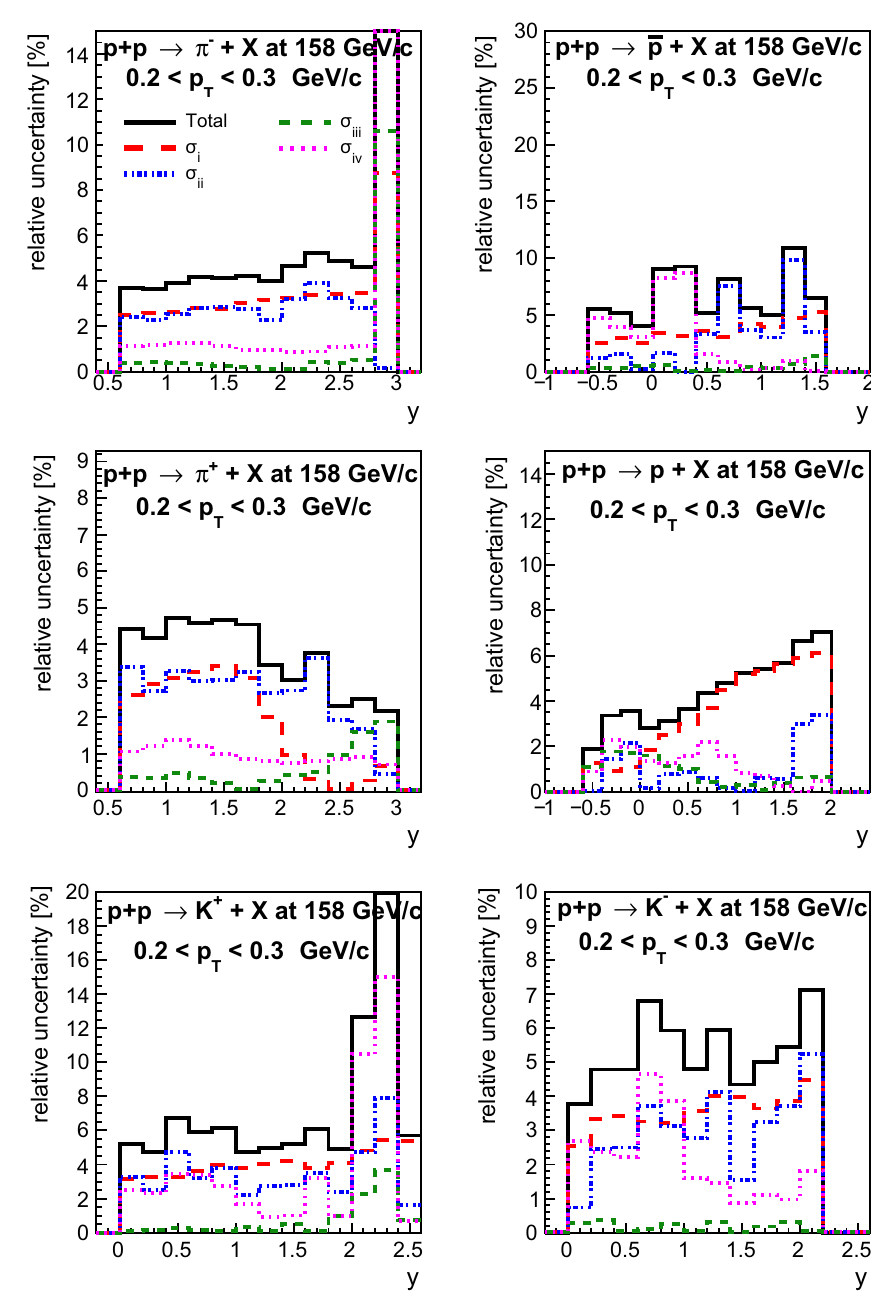
criteria (see Ref. [18]) are selected for the analysis. Tracks reconstructed in the TPCs are extrapolated to the front face of ToF-L/R where they are matched to the selected hits. The position of the extrapolation point on the scintillator tile is used to correct the measured value of tof for the propagation time of the light signal. The distribution of the difference between the corrected tof measurement and the value predicted from the track momentum and the trajectory length can be well described by a Gaussian with standard deviation of 80 ps for ToF-R and 95 ps for ToF-L. These